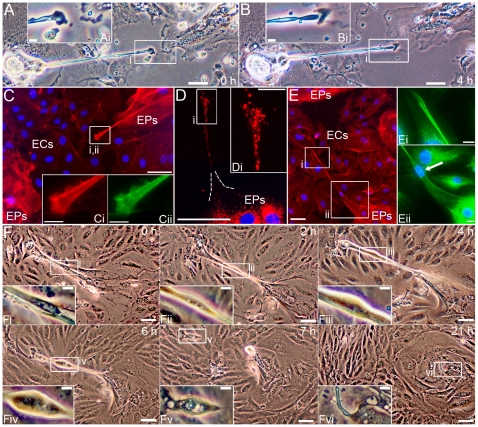
EP bridge formation via filopodia-like extensions.
A–B: Time lapse light microscopy of EP islands connecting via a filopodia-like extension over 4 h in EPs/ECs. C: F-actin (red), nucleus (blue), and acetylated α-tubulin (green) immunostaining of filopodia-like structure showed F-actin (C-Ci) and microtubule architecture (Cii) extending from an EP island toward another EP island. D: Lysosome (red) staining throughout a filopodia-like extension. E: A nucleus extended into the F-actin (red) and microtubule (green, arrow indicates nucleus) extension before a connection could be established with another EP island. F: Retraction of a type II EP bridge after EPs in a smaller EP island migrated to a larger EP island over 7 h with only remnants of the EP bridge left after 21 h. Scale bars: (A–F), 50 µm; (Ai, Bi, Ci-Cii, Di, Ei-Eii, Fi-Fvi), 10 µm.